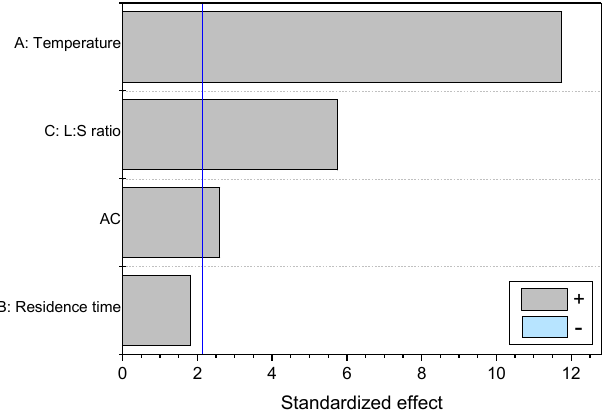
Figure 5. Pareto diagram with the significant effects on Li yield.